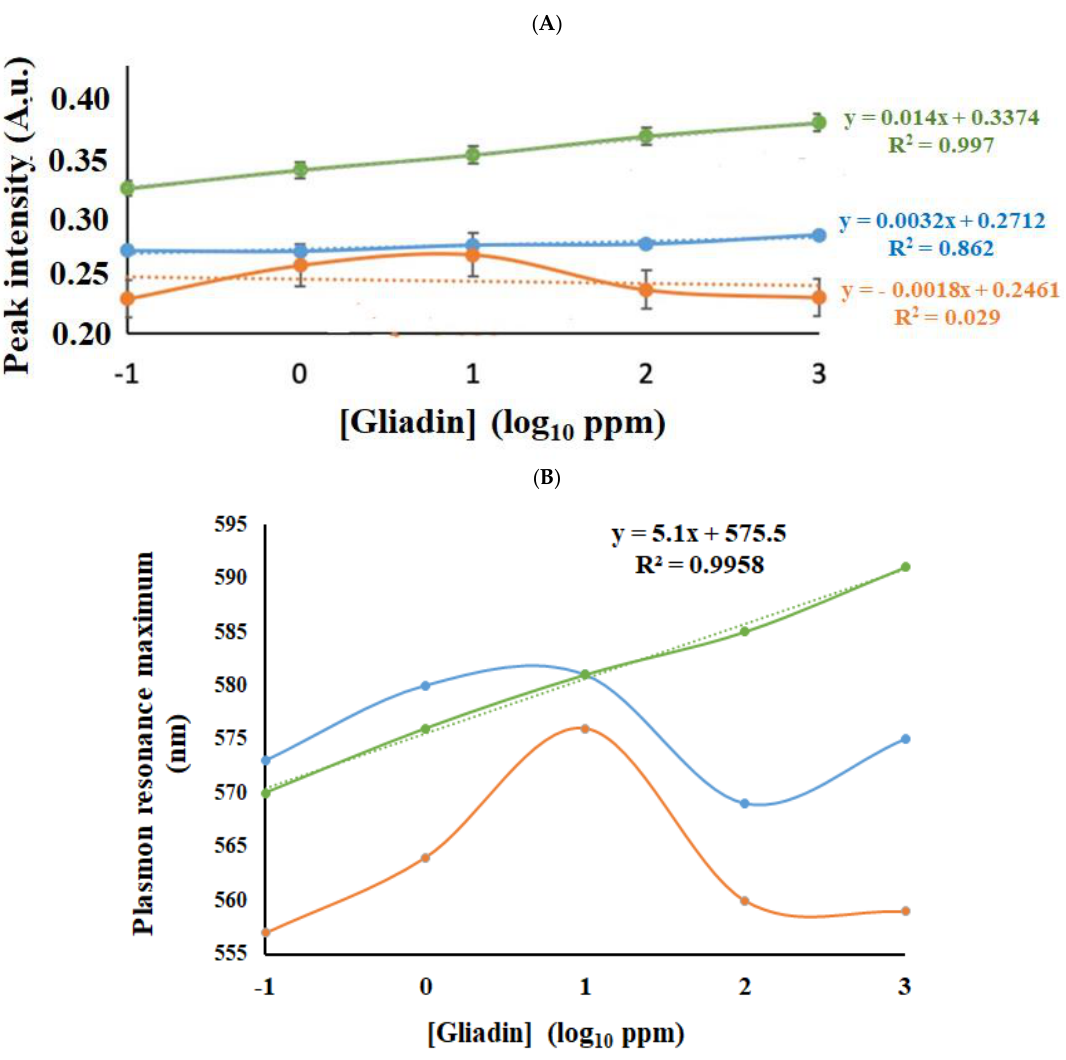
Figure 6. Dose/response curves of plasmonic peak intensity ( A ) and of the corresponding plasmon resonance maximum ( B ) for five gliadin concentrations after incubation with anti-IgG gliadin anti- bodies functionalized AuNPs suspended in three individual solutions: in 0.1 M PBS (blue color); in 70% ethanol (orange color) and in ddwater (green color).